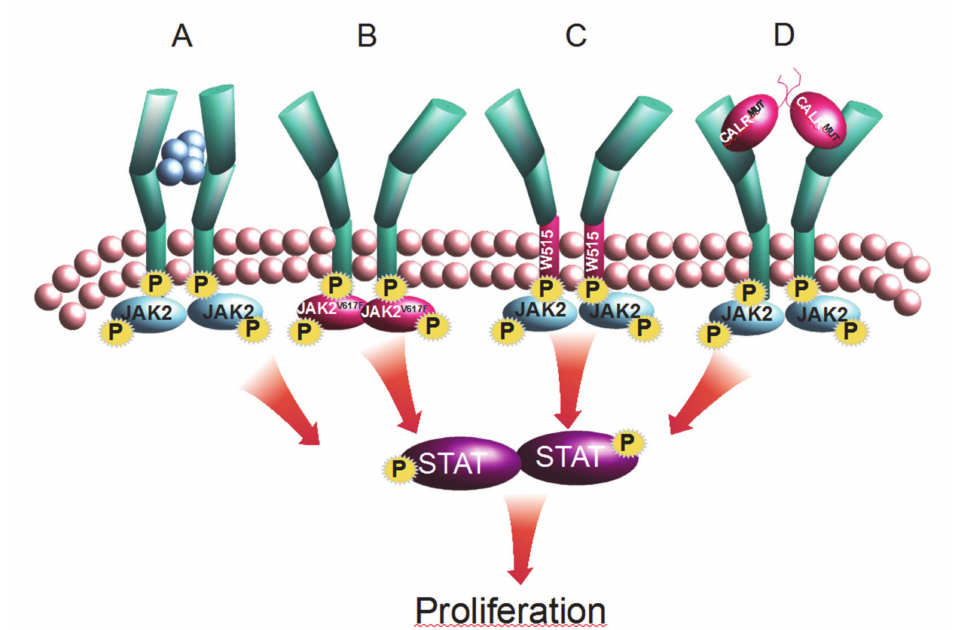
Figure 1. The phenotypic driver mutations of myeloproliferative neoplasms (MPNs) act through JAK-STAT signaling. JAK2 mediates downstream signaling for type 1 cytokine receptors such as the granulocyte colony stimulating factor receptor (G-CSFR), the erythropoietin receptor (EpoR), and, as exemplified in this figure, the thrombopoietin receptor (MPL). ( A ) In the normal cell ligand binding leads to phosphorylation of JAK2 and the receptor resulting in downstream phosphorylation of STAT proteins subsequently translocating to the nucleus where transcription of genes involved in cell proliferation and survival is initiated. ( B ) Mutated JAK2 leads to constitutively activated downstream signaling in the absence of ligand and enhanced signaling in the presence of ligand. ( C ) The MPL mutations a ff ecting peptide W515, similar to mutations in the JAK2 protein, result in constitutively activated downstream signaling. ( D ) The novel peptide of the CALR protein, resulting from the + 1-frame shift, introduces a new functionality for the CALR protein that leads to CALR-induced homo-dimerization of the MPL receptor and constitutive activation of the receptor. Proteins with mutations are depicted in red; phosphorylation is indicated with a P on yellow